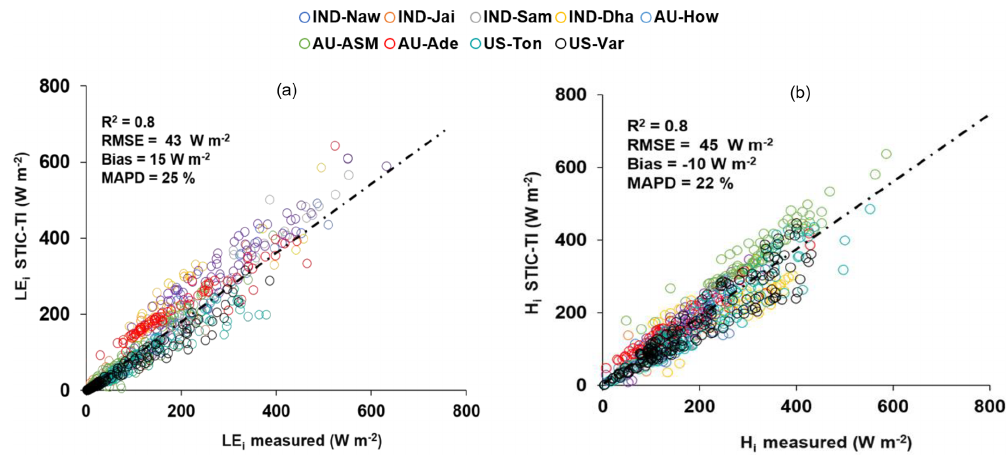
Figure 8. (a) Validation of STIC-TI LE i estimates with respect to in situ measurements in different ecosystems. (b) Validation of STIC-TI H i estimates with respect to in situ measurements in different ecosystems.